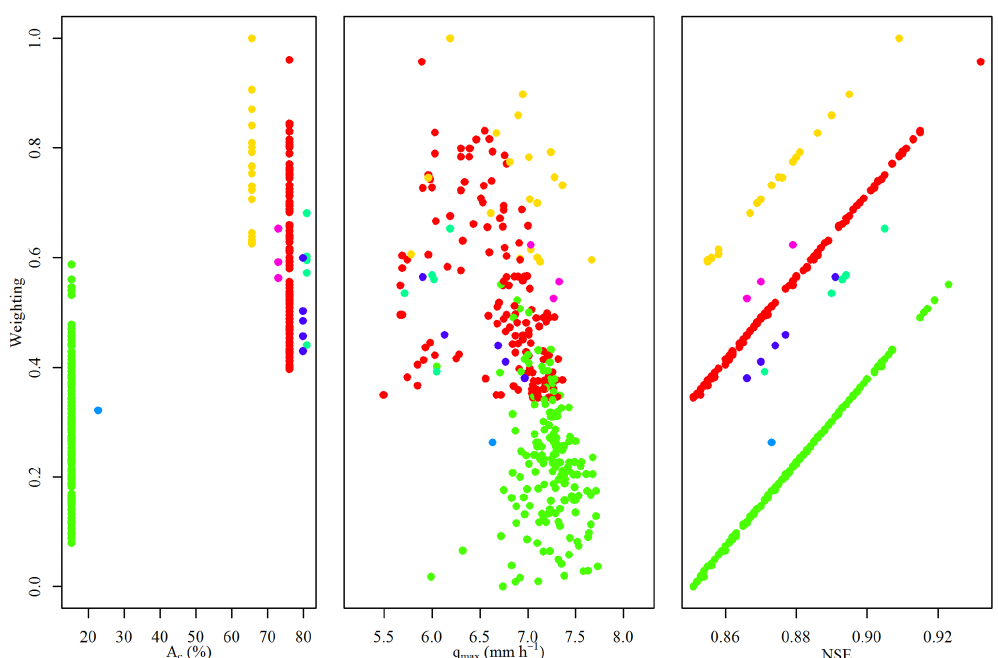
Figure 5. GLUE “dotty” plots showing overall likelihood (weighting) scores calculated for the 348 behavioural run-off simulations against the three model outputs described in the text. The discontinuous appearance of the maximum saturated contributing area A c is due to the relatively coarse discretisation applied such that once a HRU begins to produce any saturated overland flow, its entire area is added. Each unique A c value takes a separate colour that is carried through to corresponding points in the other plots. Table 3. Statistics for the impacts of interventions relative to base cases on the peaks of the named storms within the simulation period. Each difference is weighted by the likelihood score for the base-case simulation. The term (cid:49) q max (mmh − 1 ) denotes the maximum and Med the median percentage likelihood weighted reduction in peak. K.S. is Kolmogorov–Smirnov Statistic, a non-parametric statistic equal to the maximum separation of the CDF of the simulated base-case peaks versus the peaks calculated for the intervention case. This shows that the RT10 intervention consistently has the greatest impact across the storms. Abigail Barney Desmond Name (cid:49)q max Med K-S (cid:49)q